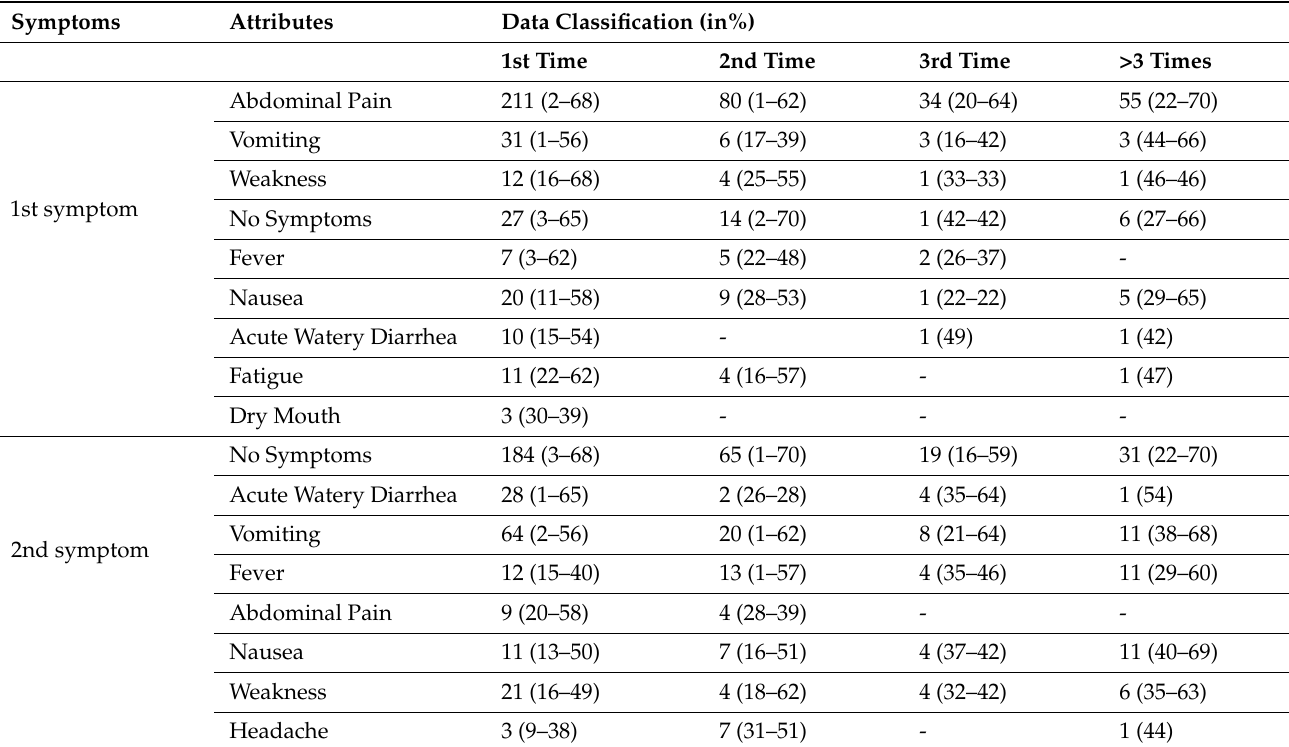
Table 10. Data classification on disease symptoms and their repetitions.